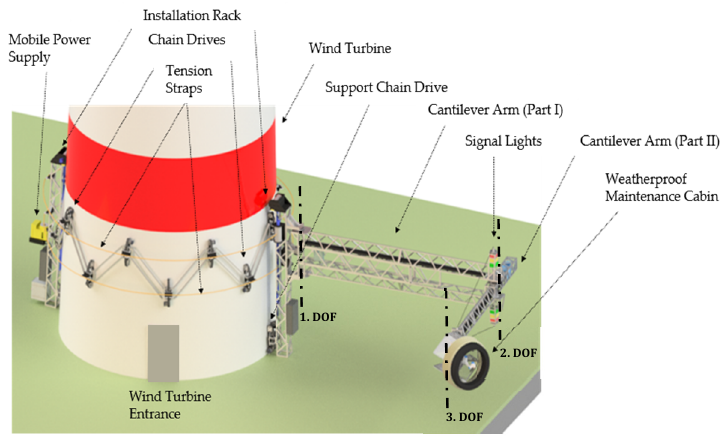
Figure 2. Climbing ring robot, SMART (Scanning, Monitoring, Analyzing, Repair and Transportation) .